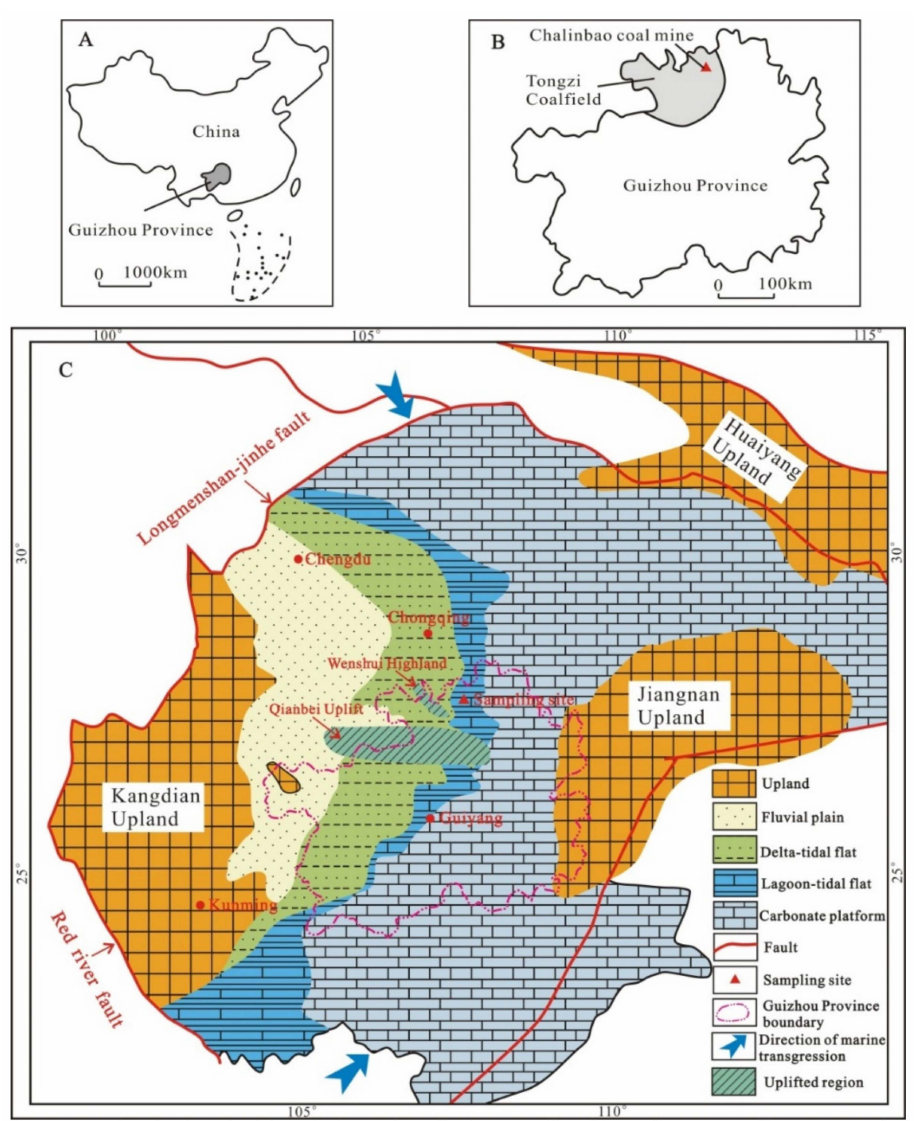
Figure 1. Maps of the study area: ( A ): Map of China showing the location of Guizhou Province, southwestern China. ( B ): Location of the Tongzi Coalfield. ( C ): Palaeogeography of early Late Permian period modified from